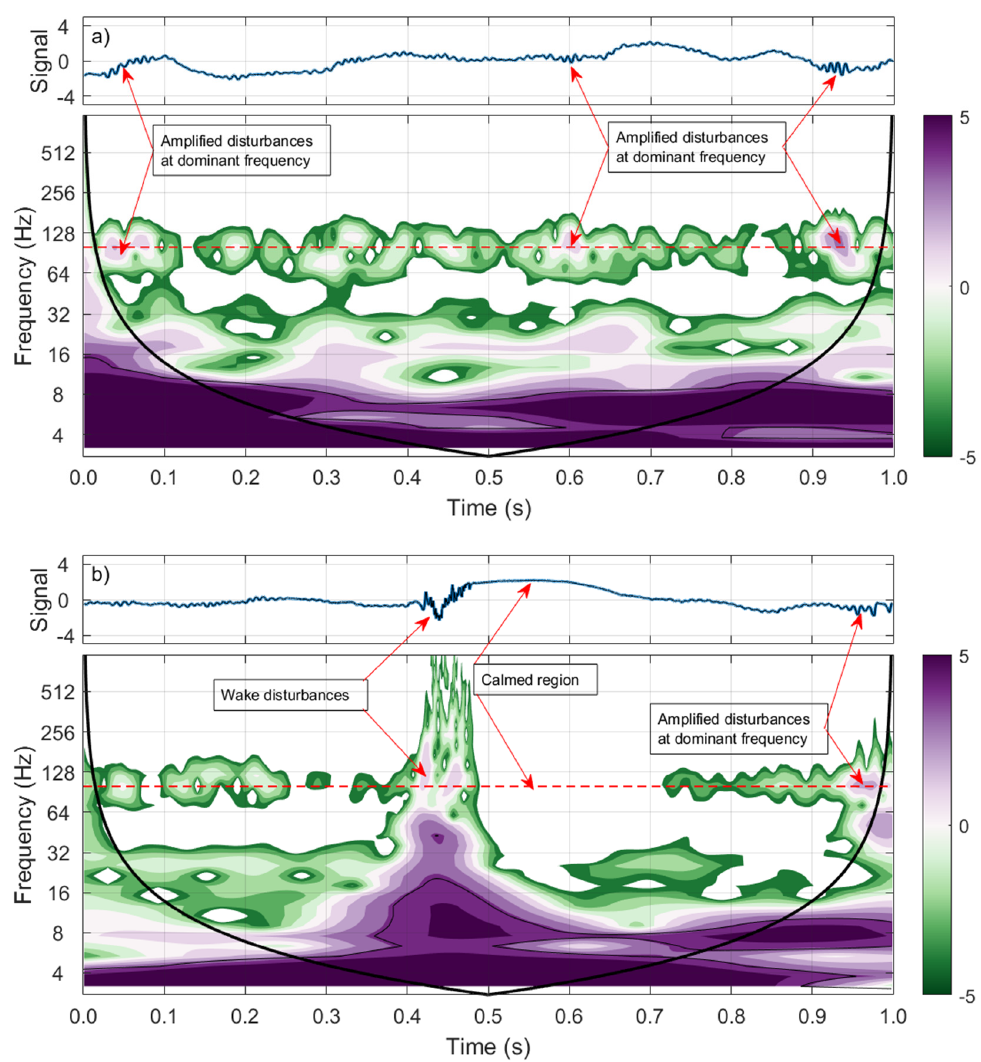
Figure 9. Wavelet transform contours for ( a ) steady-inlet and ( b ) wake-inlet. The dashed red line represents the dominant frequency in the frequency hump (100 Hz).